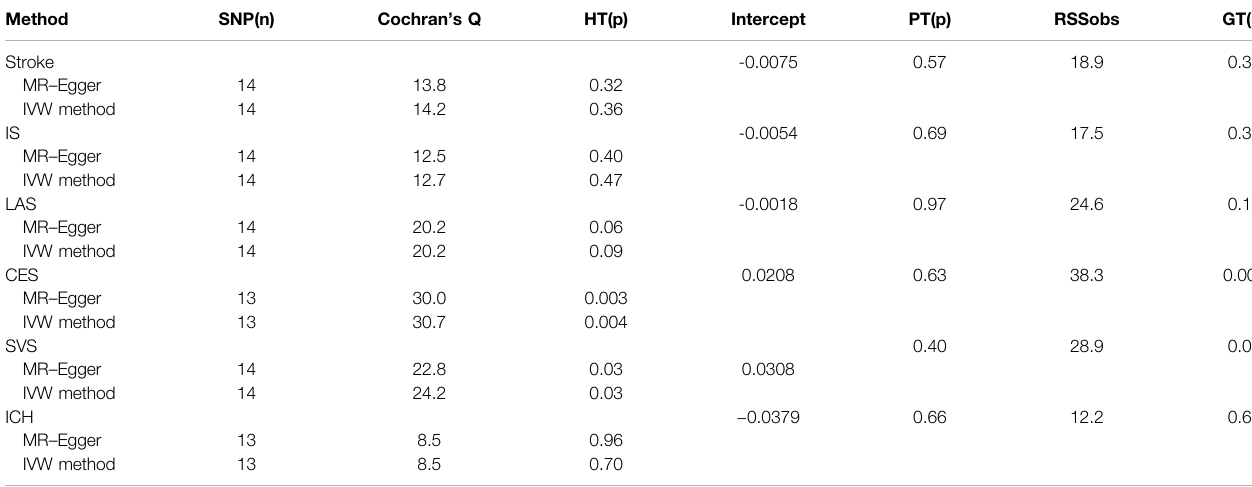
TABLE 1 | Sensitivity analysis of childhood obesity and stroke in MR analysis. Method